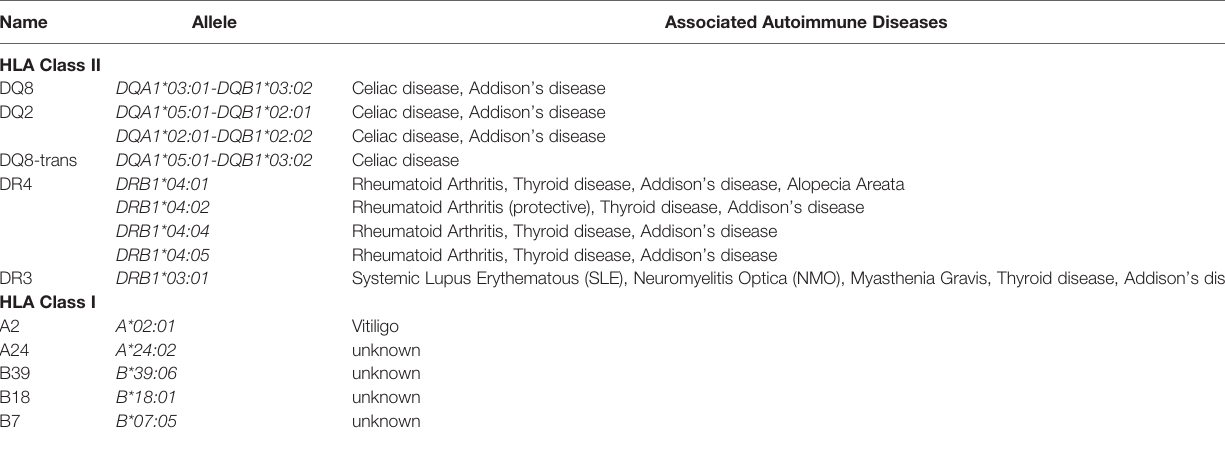
TABLE 1 | Common HLA alleles associated with type 1 diabetes